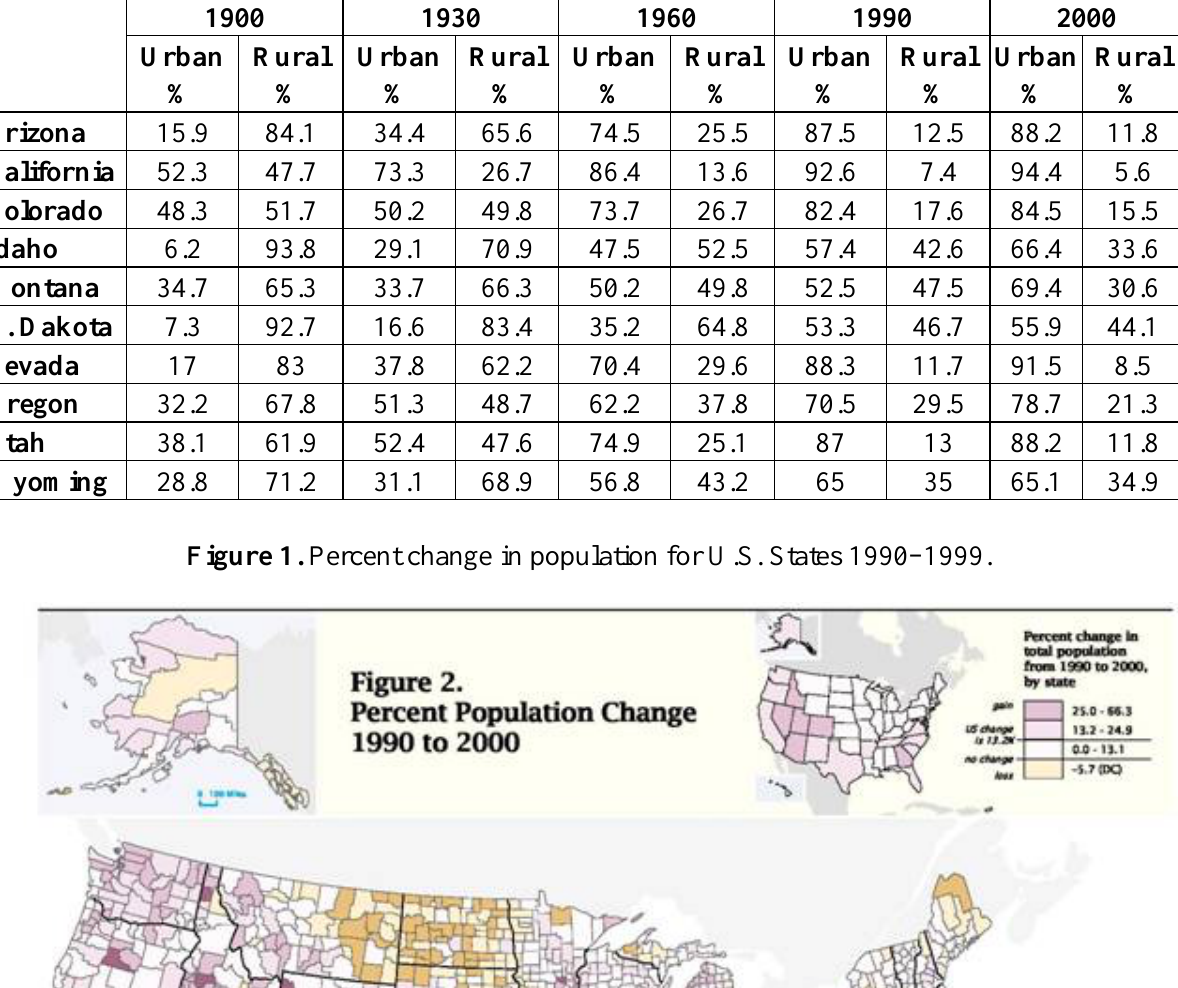
Table 1. Percent of urban/rural population from 1900–2000 [10].